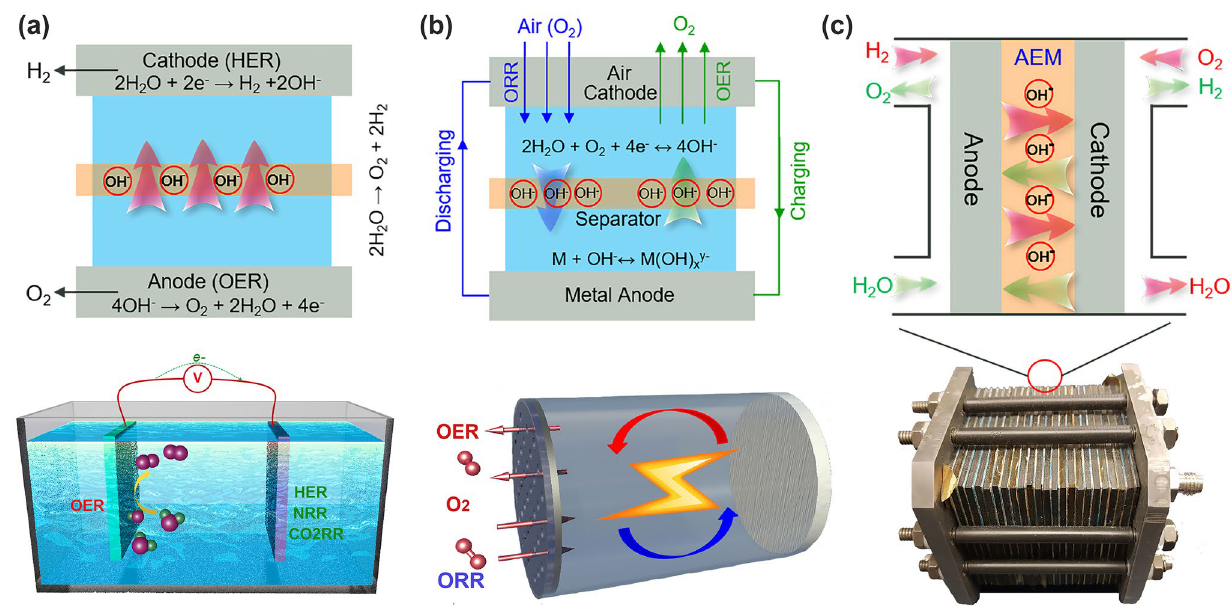
Fig. 1 The OER in electrochemical energy conversion and storage devices. a Electrolyzers for small molecules’ electrolysis, b metal–air batter- ies, and c regenerative fuel